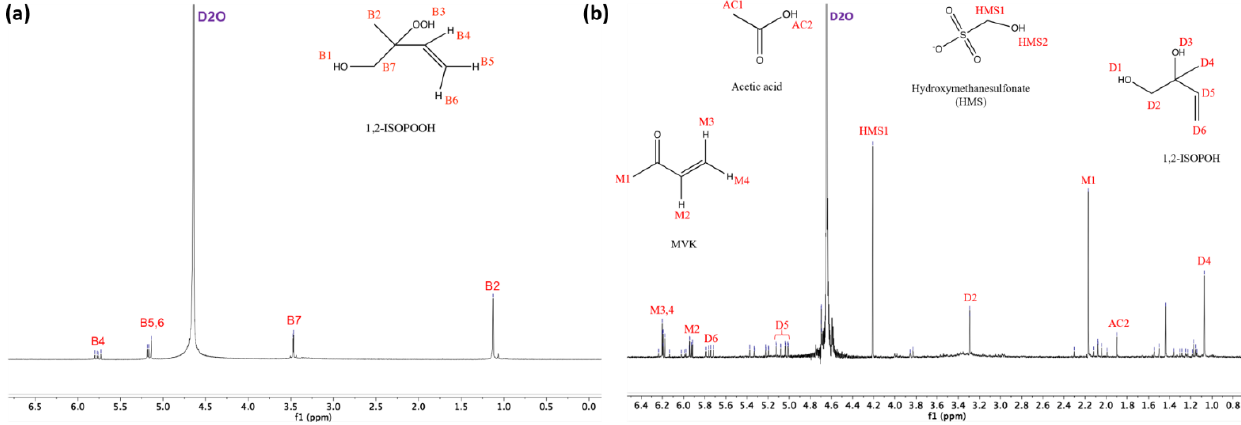
Figure 2. Proton NMR spectra ( 1 H-NMR, 400MHz, D 2 O) for 1,2-ISOPOOH (a) , and products of the reaction of SO 2 , aq + 1,2- ISOPOOH (b) . The marked peaks represent the position of the hydrogens for each molecule. The pH of the samples was 5.5 and the concentrations used were [1,2-ISOPOOH] = 1mM and [SO 2 , aq ] = 2mM. D 2 O shift at